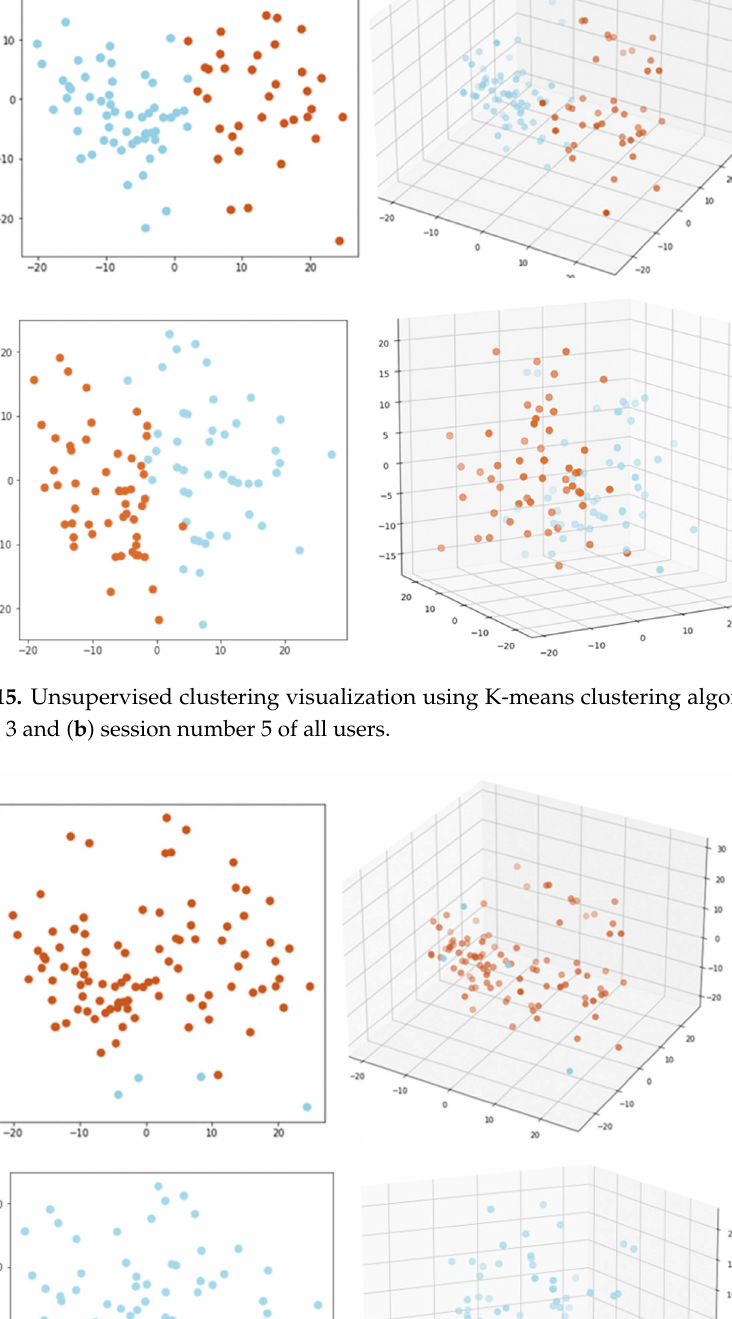
Figure 14. Unsupervised clustering visualization using SOM: ( a ) session number 3 and ( b ) session number 5 of all users.